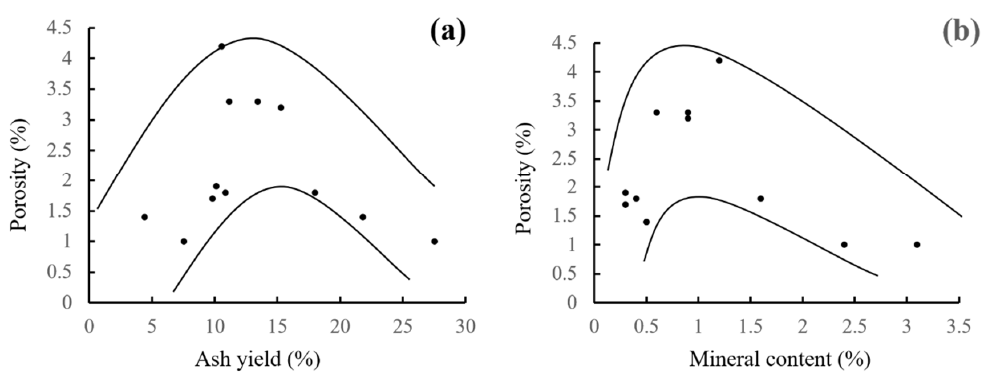
Figure 4. Relationship between the porosity and the ash yield ( a ) and mineral content of coal ( b ). Three types of mercury injection curves were classified of 14 coal samples as shown in Table